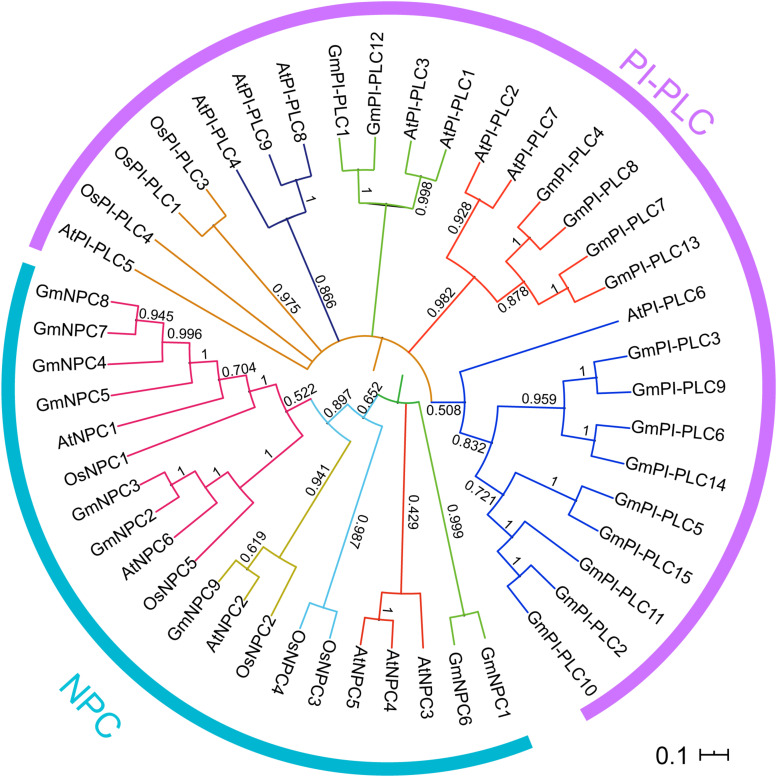
Phylogenetic relationships of the PI-PLC and NPC gene families in soybean, rice and Arabidopsis. The complete amino acid sequences of the PLC proteins were aligned by Clustal W and maximum-likelihood estimation with MEGA7. Two discrete groups are highlighted in different colors.